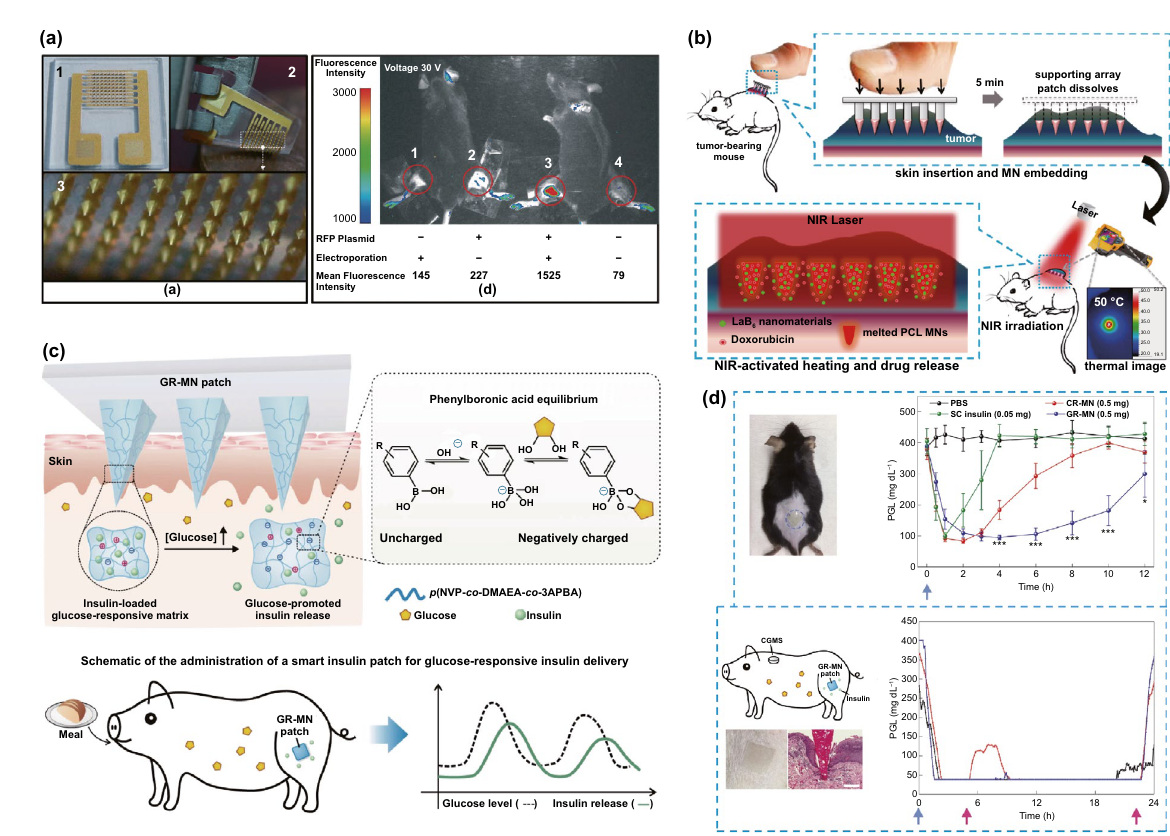
Fig. 11 Microneedle‑based therapies with on‑demand drug release. a Left: conductive microneedle array interdigitated electrode for elec‑ troporation. Right: Microneedle electroporation treatment effectively enhanced the expression of pmRFP‑C1 (RFP) plasmid (area 3) [224]. b Schematics of near‑infrared (NIR)‑light‑triggered transdermal controlled‑release microneedles for chemotherapy and photothermal treatment of tumor on mice model [228]. c Illustrations of glucose‑triggered insulin release from glucose‑responsive microneedle (GR‑MNs) and the applica‑ tion of GR‑MNs on diabetic minipig model [230]. d Effective and rapid regulation of plasma glucose levels (PGL) in insulin‑deficient diabetic mice (upper) and minipigs (bottom). Blue arrows: time points of microneedle administration. Pink arrows: time points of feeding [230]. Repro‑ duced with permission from Refs. [224, 228, 230], copyright (2014) The Royal Society of Chemistry, (2016) American Chemical Society Pub‑ lishing Group and (2020) Nature Publishing